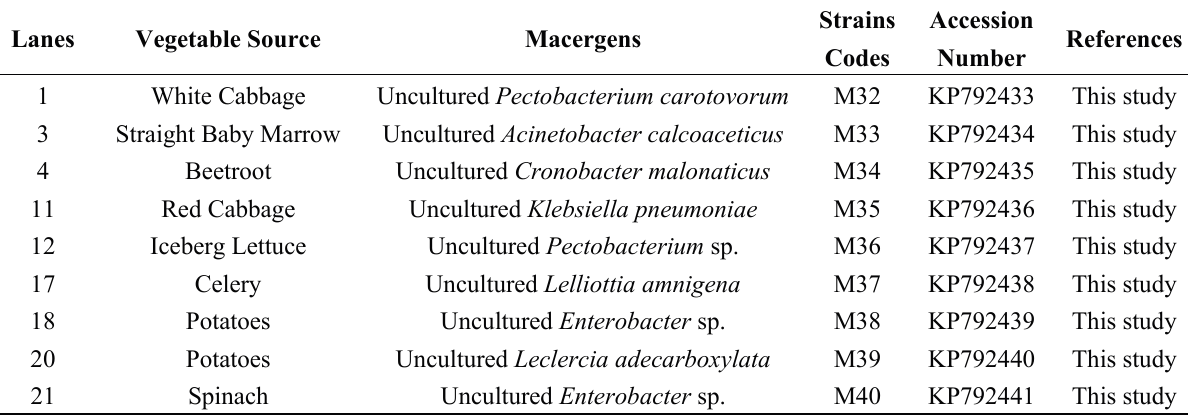
Table 4. Macergens detected by Set 3 primers from the rotten